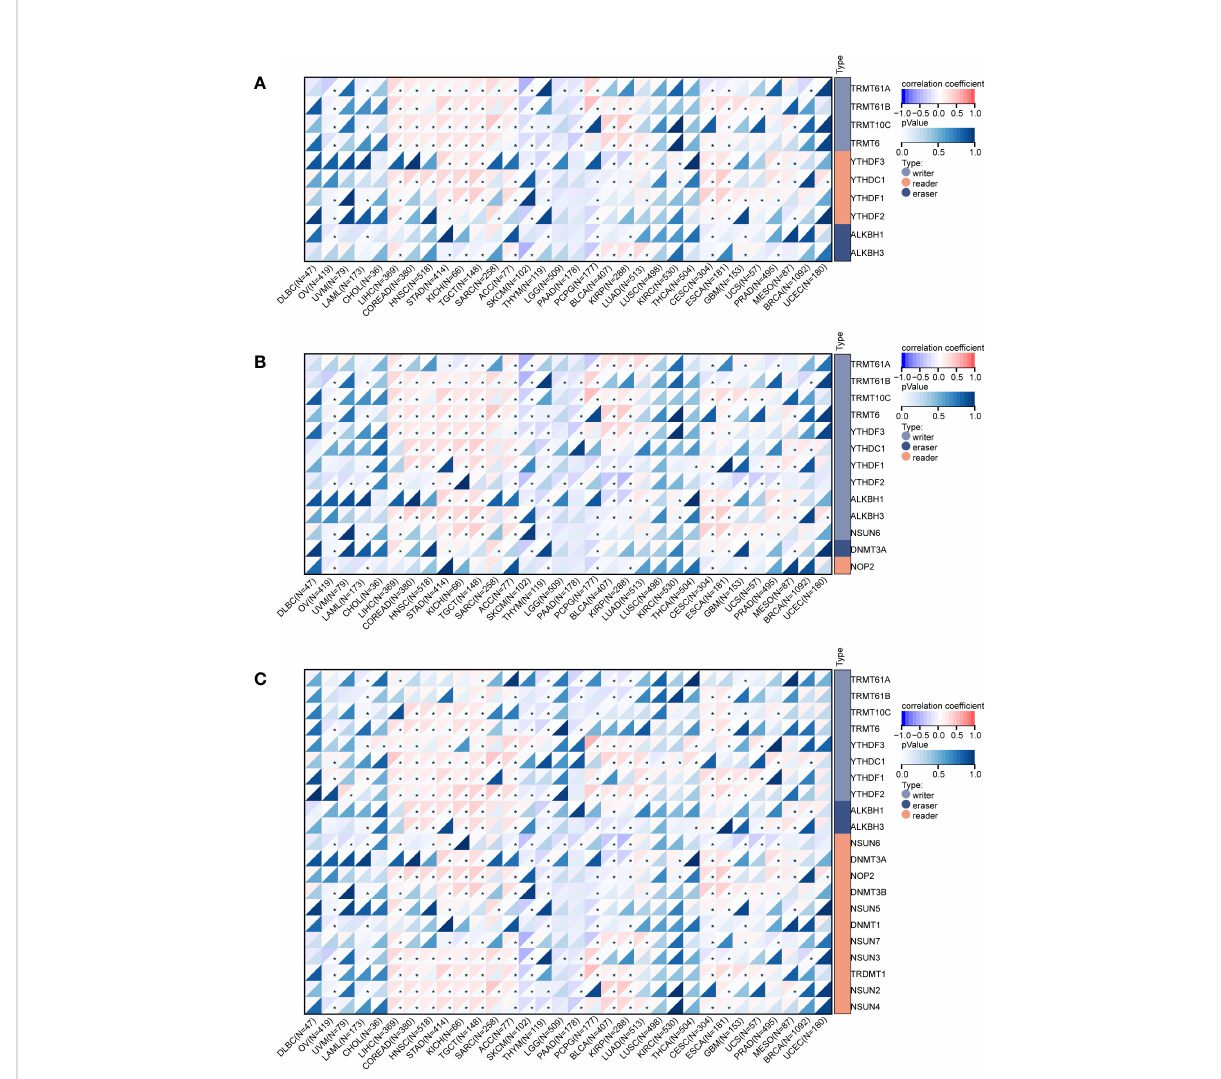
FIGURE 5 Correlation of DEF6 expression with RNA-modi fi ed genes. Correlation of DEF6 expression with (A) m1A-, (B) m5C-, and (C) m6A-modi fi ed gene expression in multiple